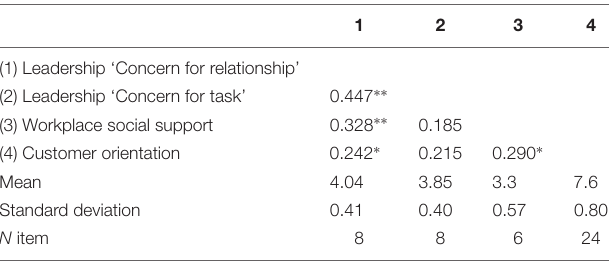
TABLE 1 | Correlations (Pearson’s r ) and descriptive statistics of the scales ( N = 57).